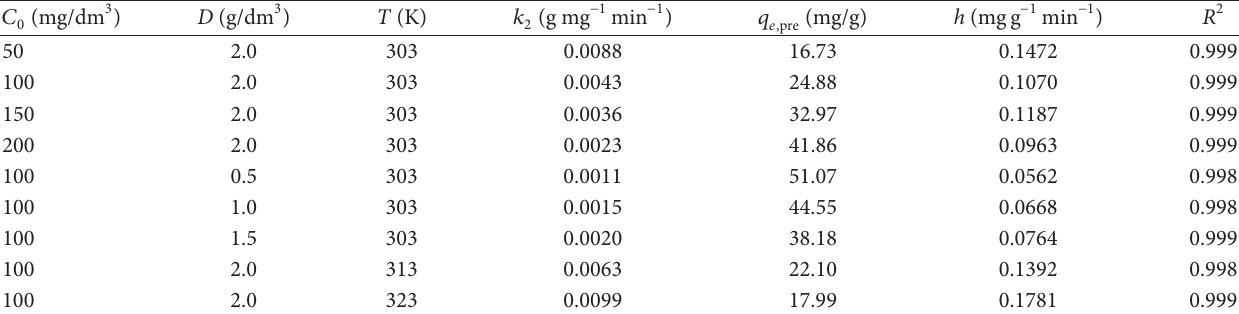
T 2: Effect of concentration, adsorbent dosage, and solution temperature on adsorption of MB onto